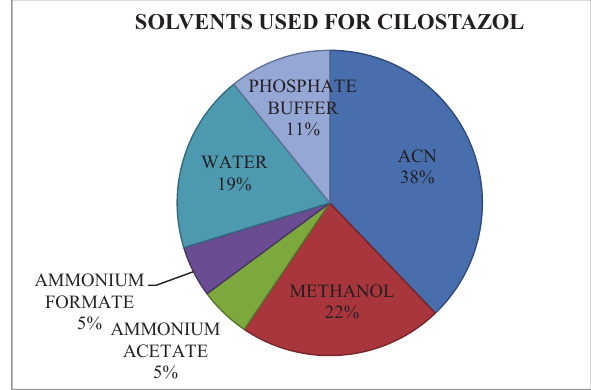
Figure 2: Graph displaying the various solvents used for cilostazol.